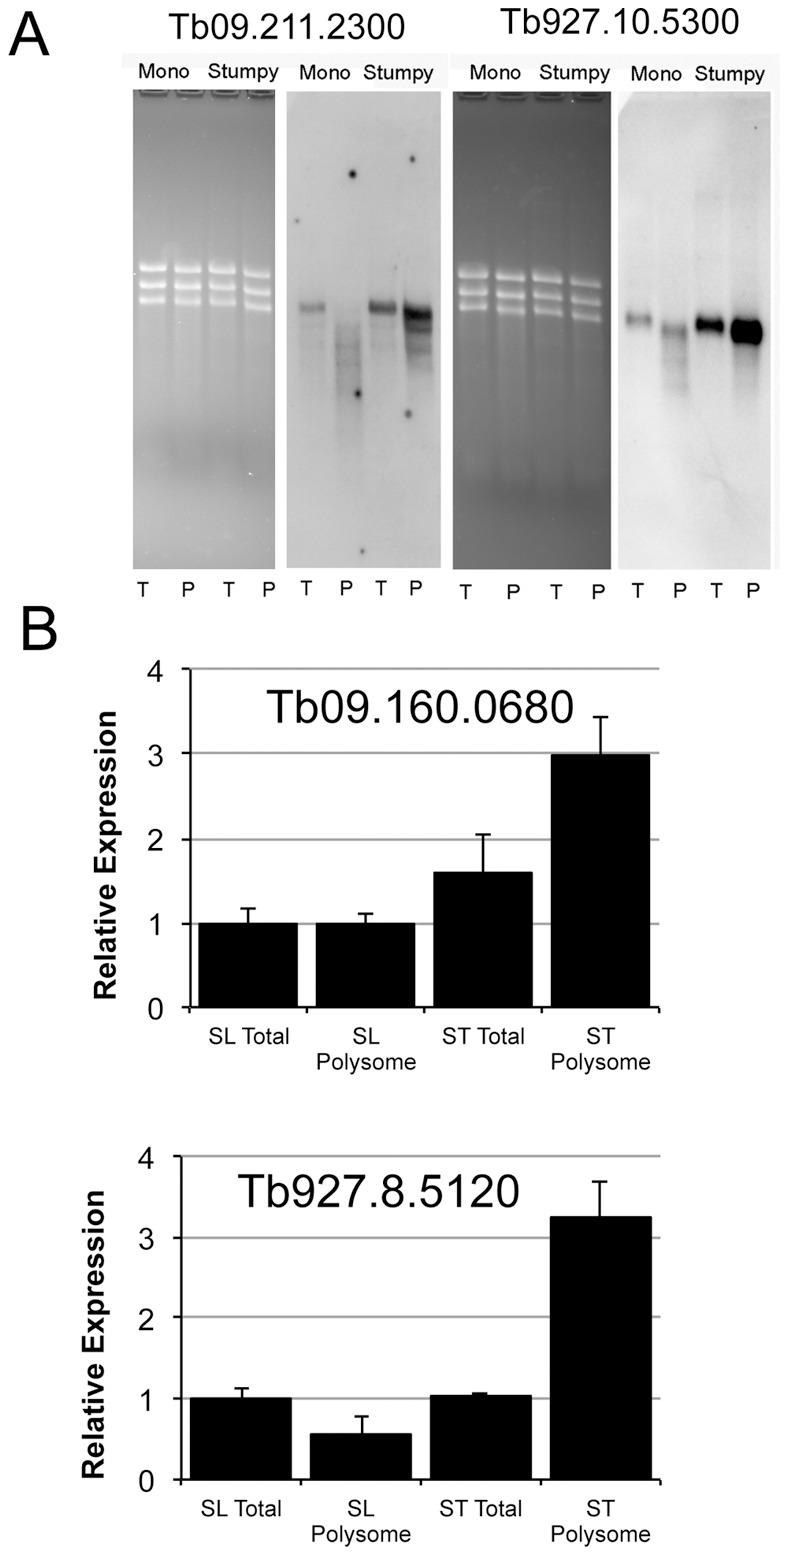
Validation of the polysomal enrichment of test mRNAs predicted from Digital SAGE analysis to exhibit elevated abundance in stumpy polysomal fractions.Total (T) and polysomal (P) mRNA mRNA derived from monomorphic slender and pleomorphic stumpy forms is shown, these being hybridized with riboprobes detecting Tb09.211.2300, or Tb927.8.5120. Both transcripts were confirmed as showing enrichment in stumpy form polysomal RNAs with respect to both stumpy total RNA and slender total and polysomal mRNA. Some smearing is evident in the polysomal material of slender and stumpy forms reflecting some non-specific cross reactivity with other transcripts; an absence of significant RNA degradation is evidenced by the integrity of rRNA bands on the ethidium bromide-stained formaldehyde gel. Realtime qRT PCR of two further transcripts provided confirmation of their respective enrichment in polysome-derived material.